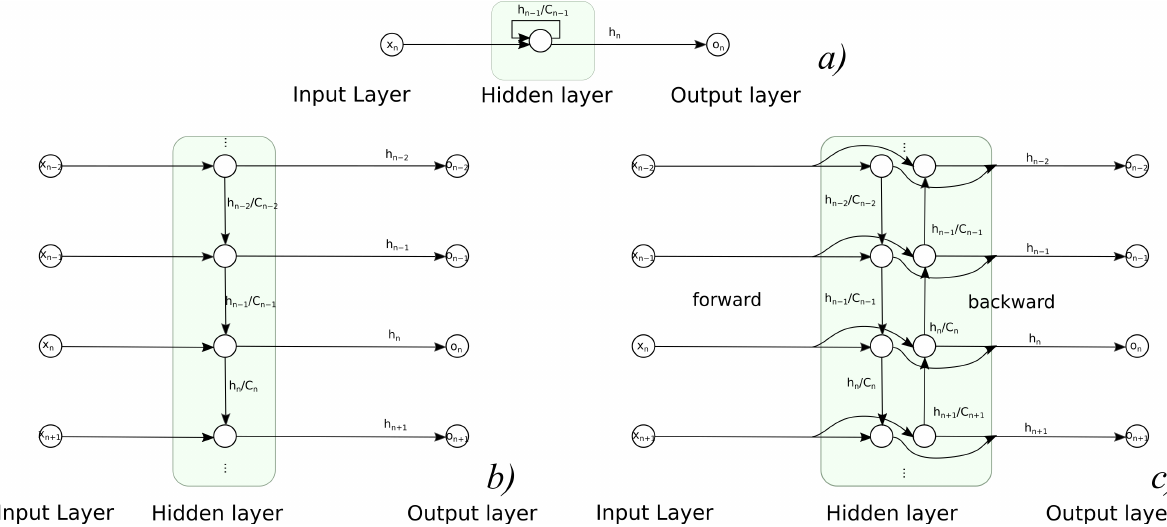
Figure 4. Usage of recurrent NNs in sequence to sequence task: ( a ) folded, ( b ) unfolded unidirectional variant, ( c ) unfolded bidirectional variant.